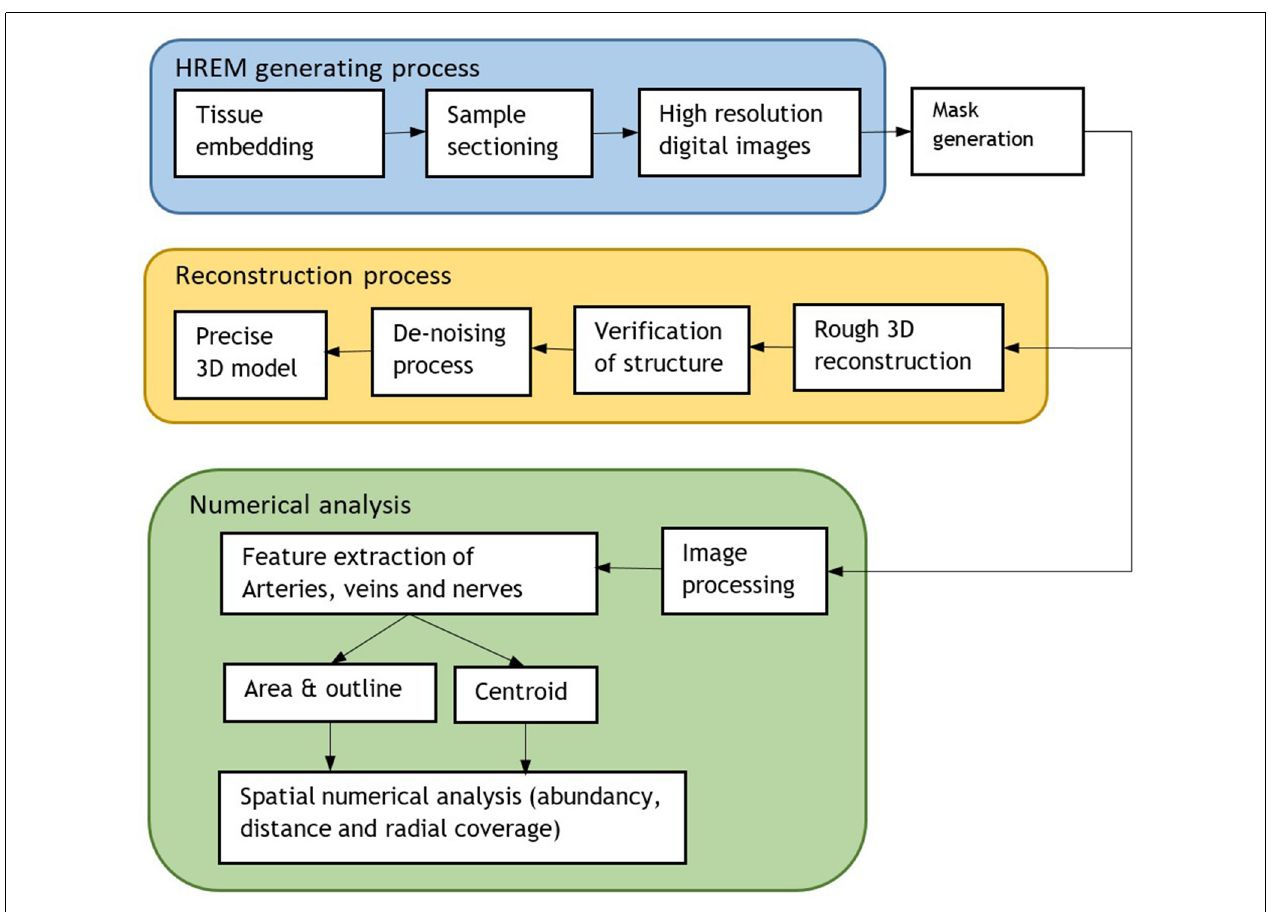
FIGURE 2 | Flowchart of the whole process including the HREM generation for 3D model reconstruction and numerical